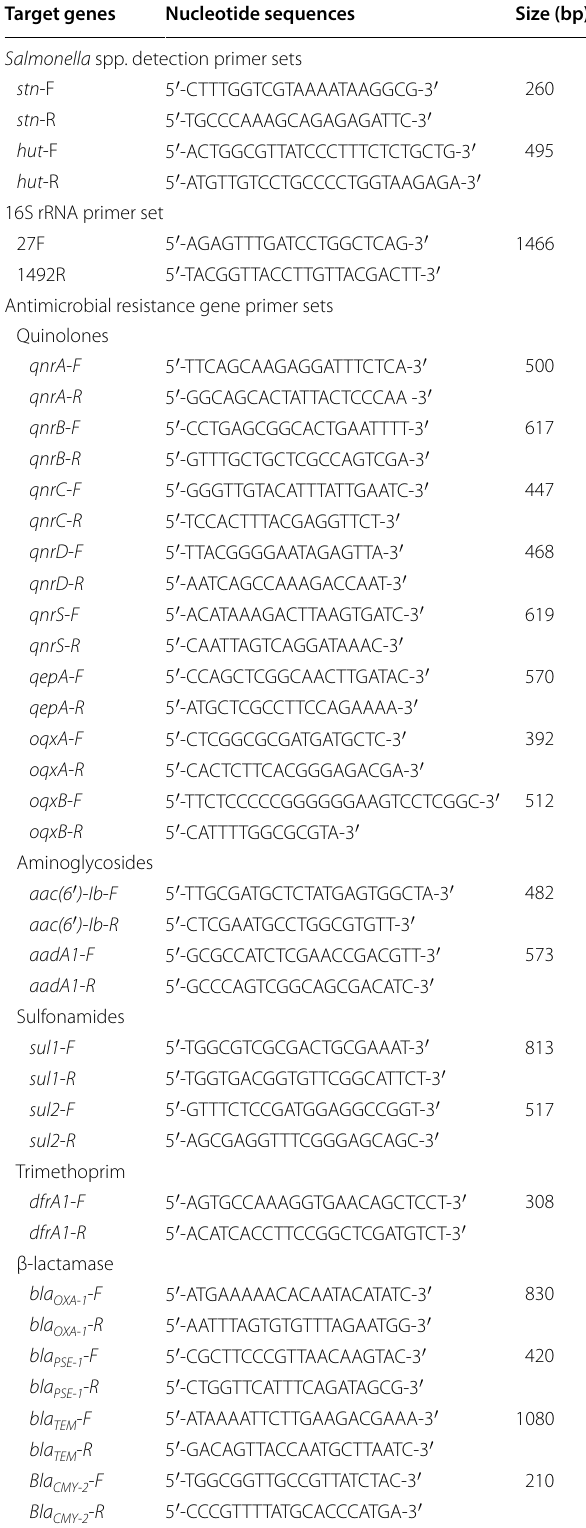
Table 1 (continued) Target